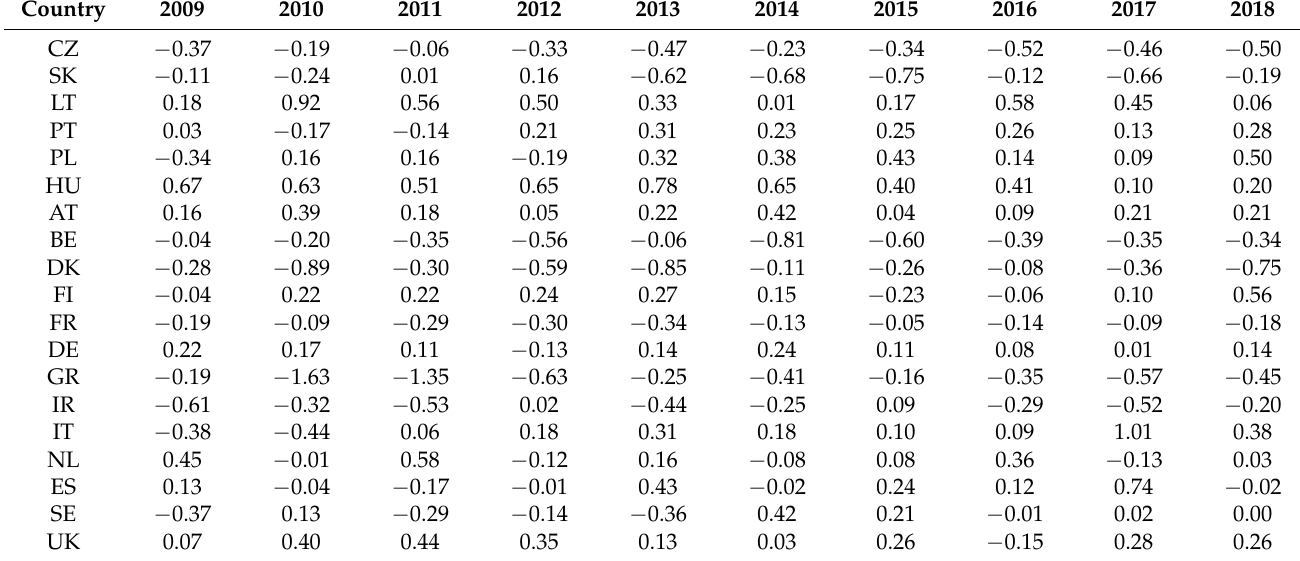
Table 3. EU non-metallic minerals industry (ISIC 23) competitiveness measure index, 2009–2018. Source: own processing.